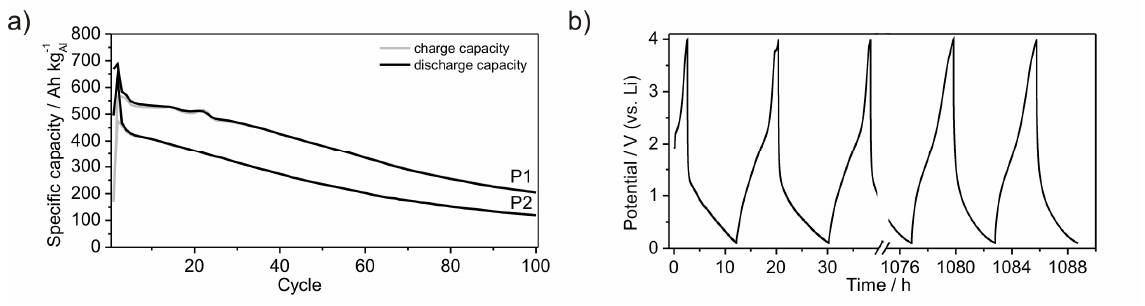
Figure 9. Development of specific capacities of amorphous Al P2, galvanostatically cycled between 0.1 V and 4 V with a rate of C/20 over 100 cycles ( a ); Voltage profile of powder P1 ( b